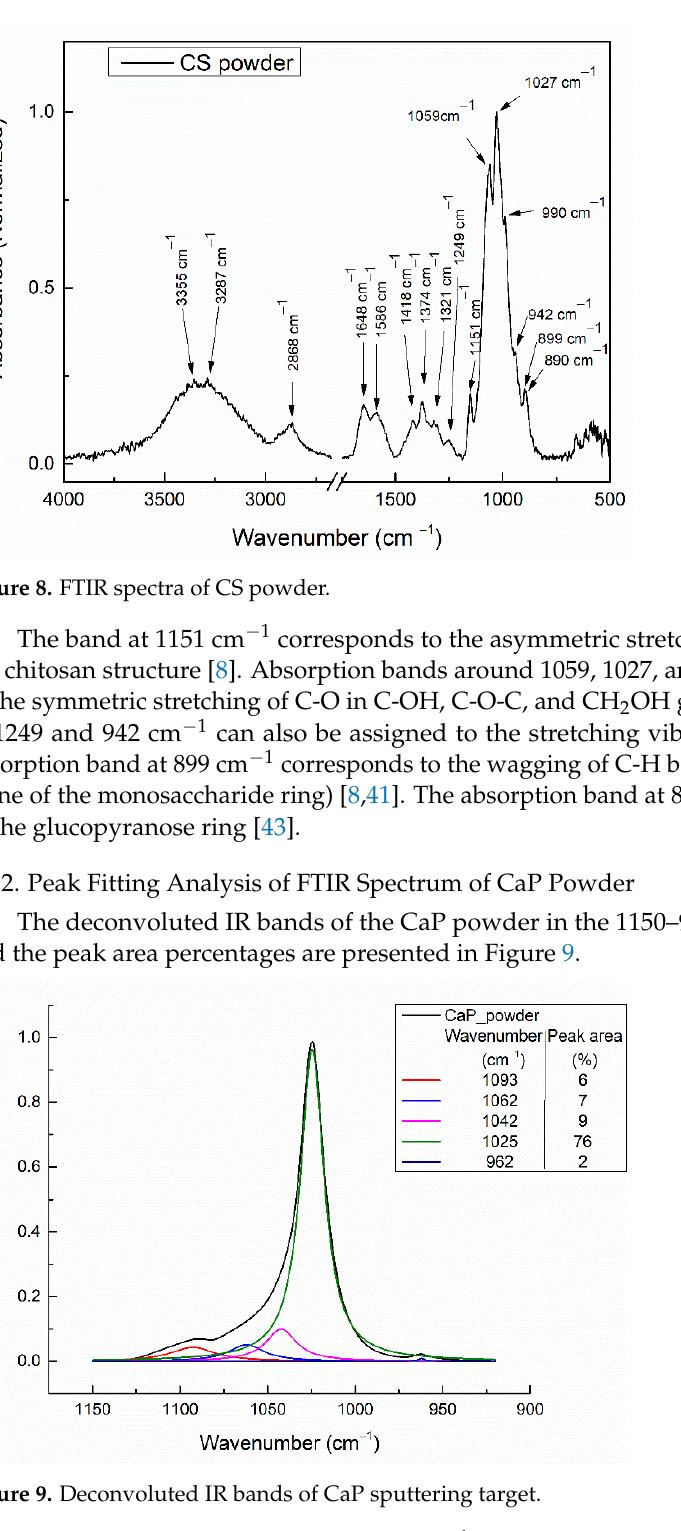
11 of 27 Figure 7. FTIR spectra of the CaP powder and of the CaP coatings deposited at different substrate temperatures (CaP_1, CaP_2, and CaP_3).